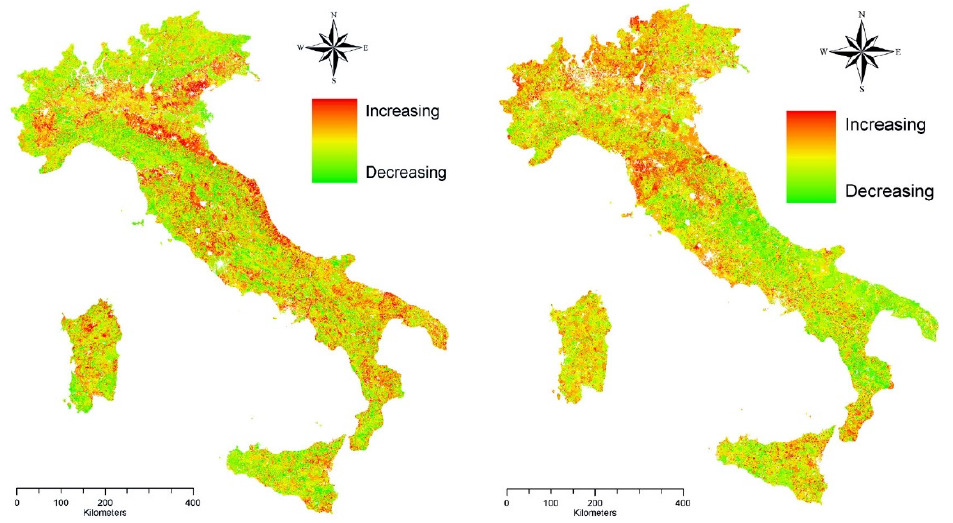
Figure 2. Differences over time in the Environmentally Sensitive Area Index (ESAI) in Italy ( left : 1960–1990; right : 1990–2010).